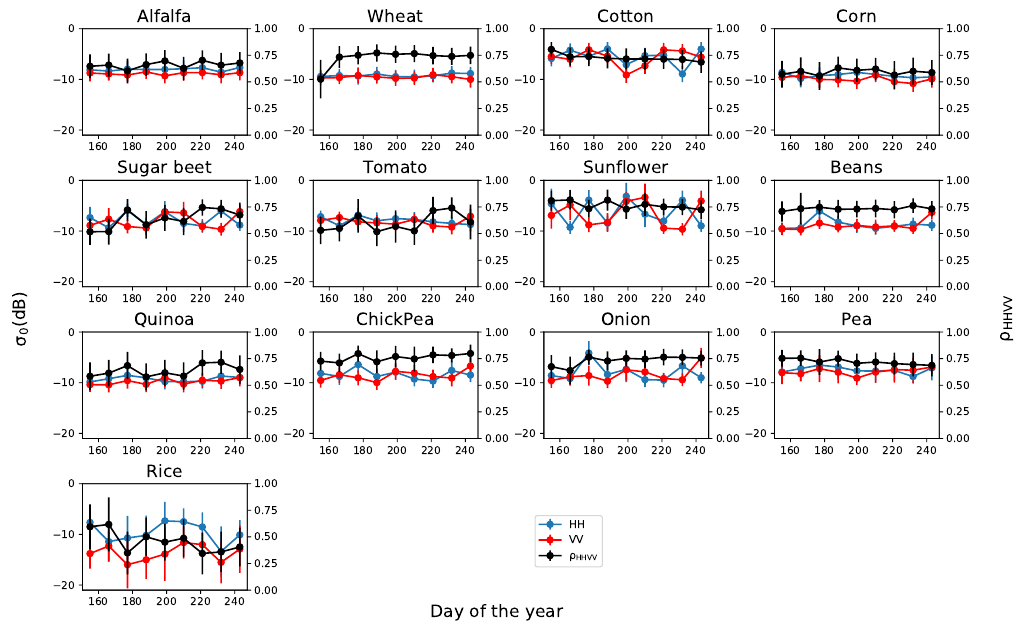
Figure 4. Temporal evolution of the backscattering coefficient at HH (blue) and VV (red) channels and their correlation (black) for all crop types. Dots represent the average values and the error bars denote the standard deviation of the